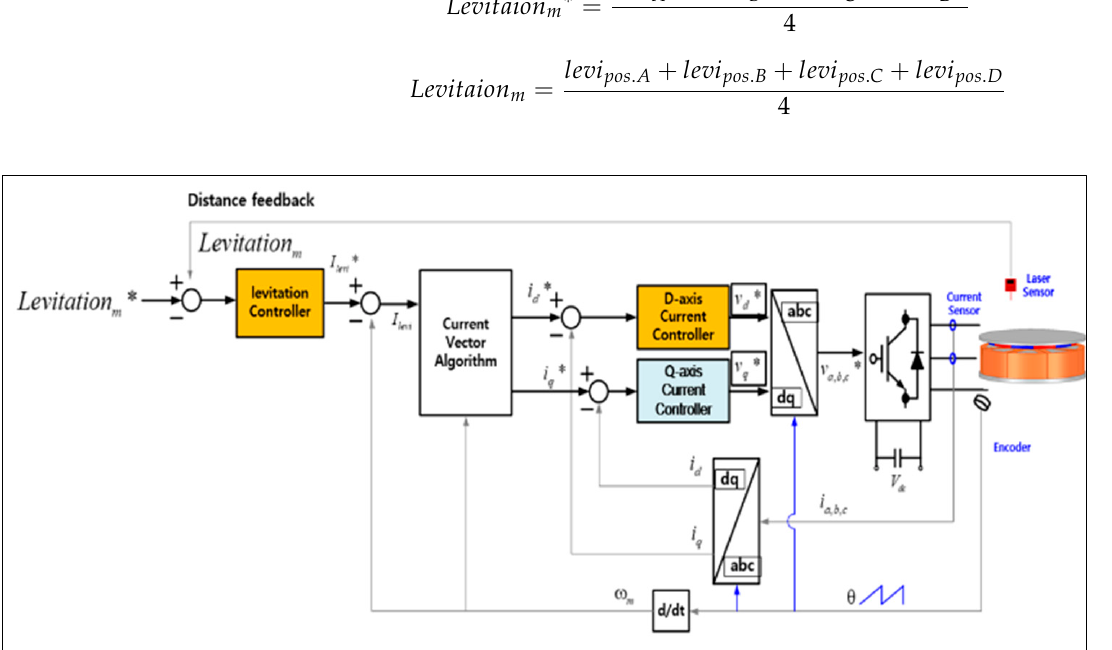
Figure 4. Control block diagram for the levitation (* is command value).